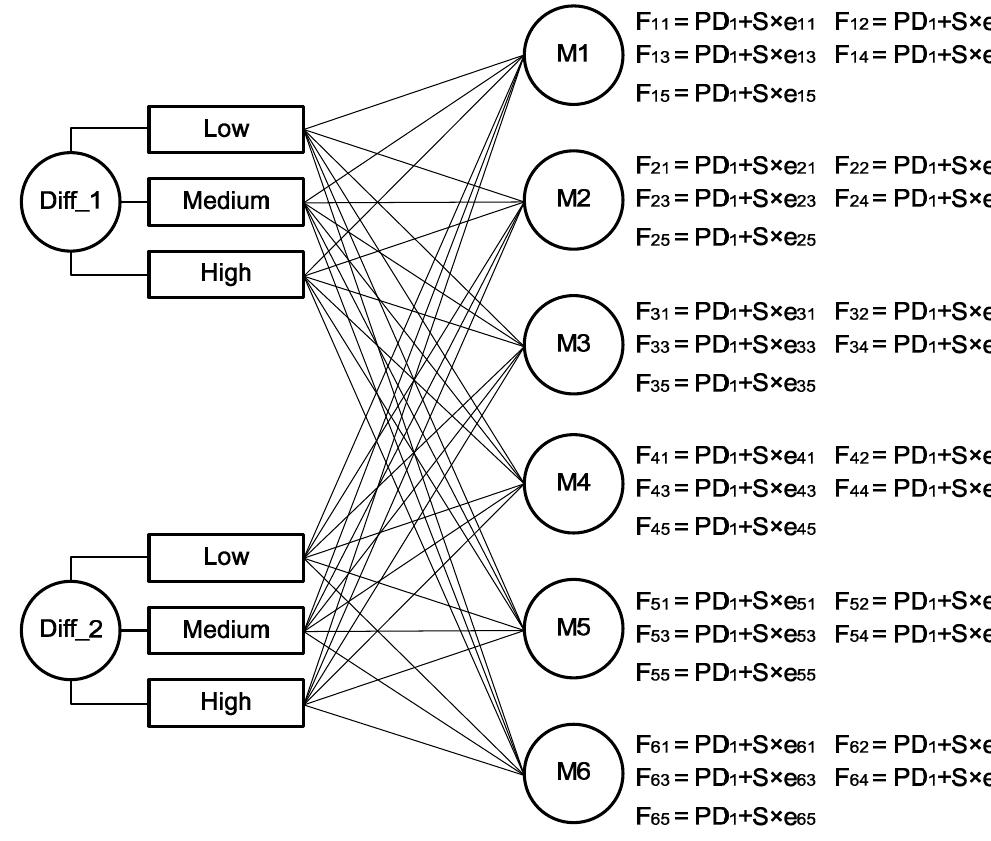
Figure 2. Fuzzy decision rules of the proposed prediction methodology for EEG signal.